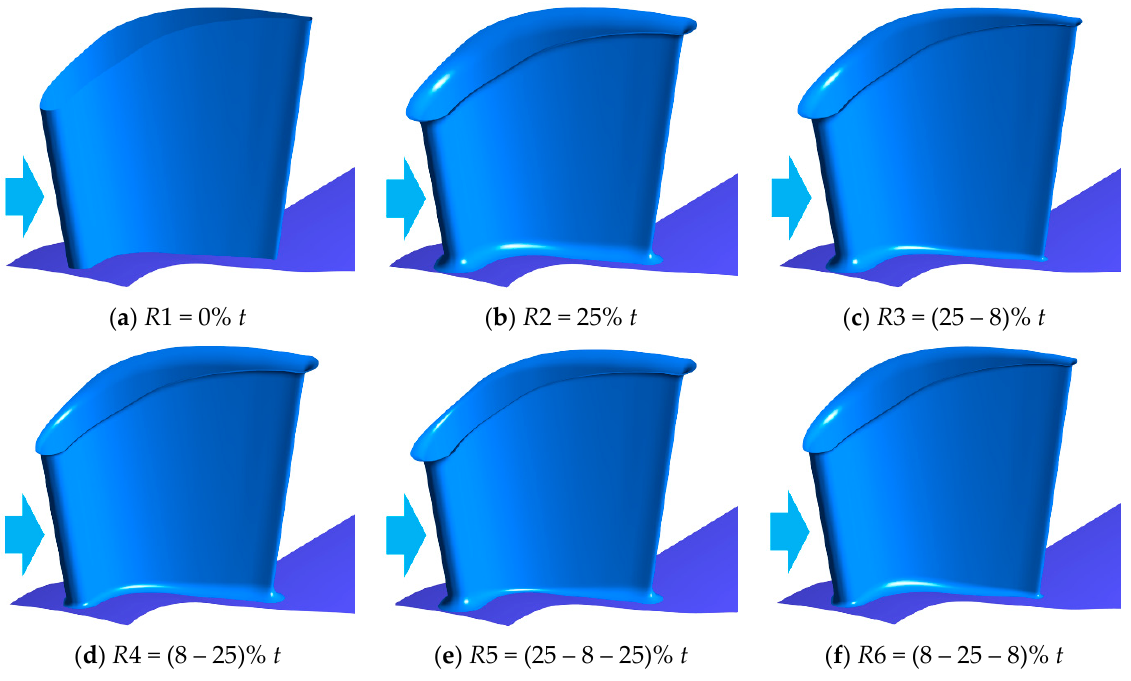
Figure 8. Three-dimensional (3D) schematic diagram of S2 with fillet.